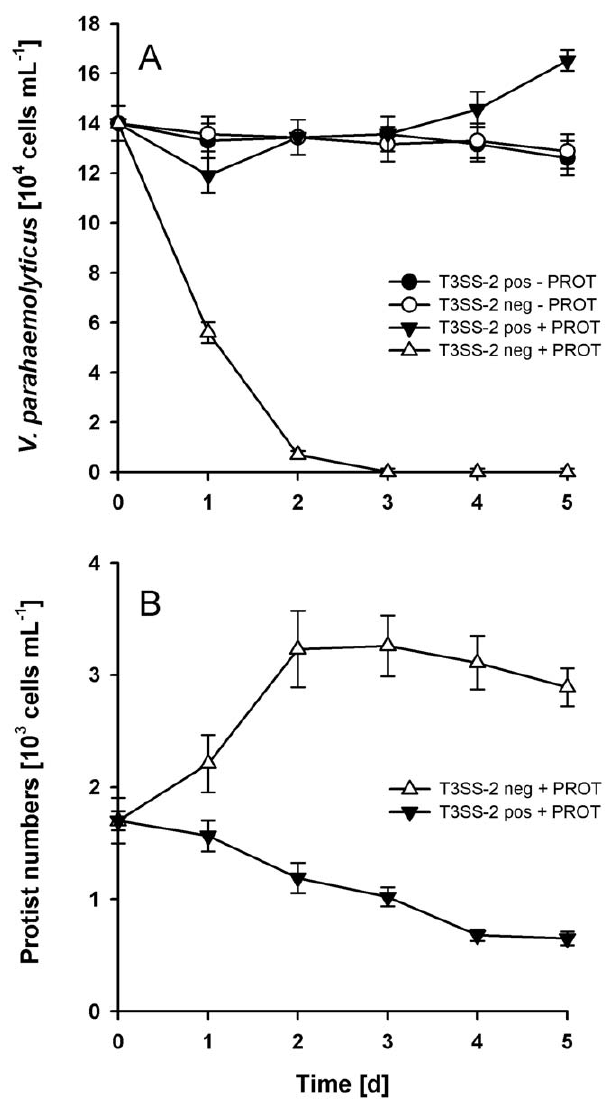
Figure 4. Invasion of T3SS-2 positive V.parahaemolyticus into coastal plankton community. Microcosms containing natural plankton communities were inoculated with the T3SS-2 positive wild type RIMD2210633 and the T3SS-2 deficient mutant POR3. (A) Survival of V. parahaemolyticus is given as relative change of initial cell numbers in the presence ( + PROT) and absence ( 2 PROT) of the natural protist community. (B) relative changes in total protist numbers are given for the protist microcosms. Error bars represent standard deviations (n=4).